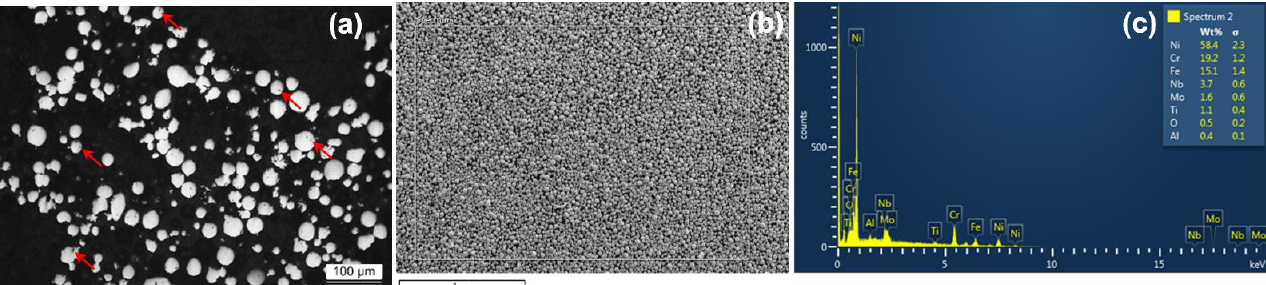
Figure 5. IN718 pre-alloyed powder. ( a ) OM micrographs of particle cross-sections (200X) arrows indicate the porosities revealed. ( b ) FESEM of powder particles, and ( c ) Measurements of chemical composition by EDS (1000X, 20 kV, Mode SE).